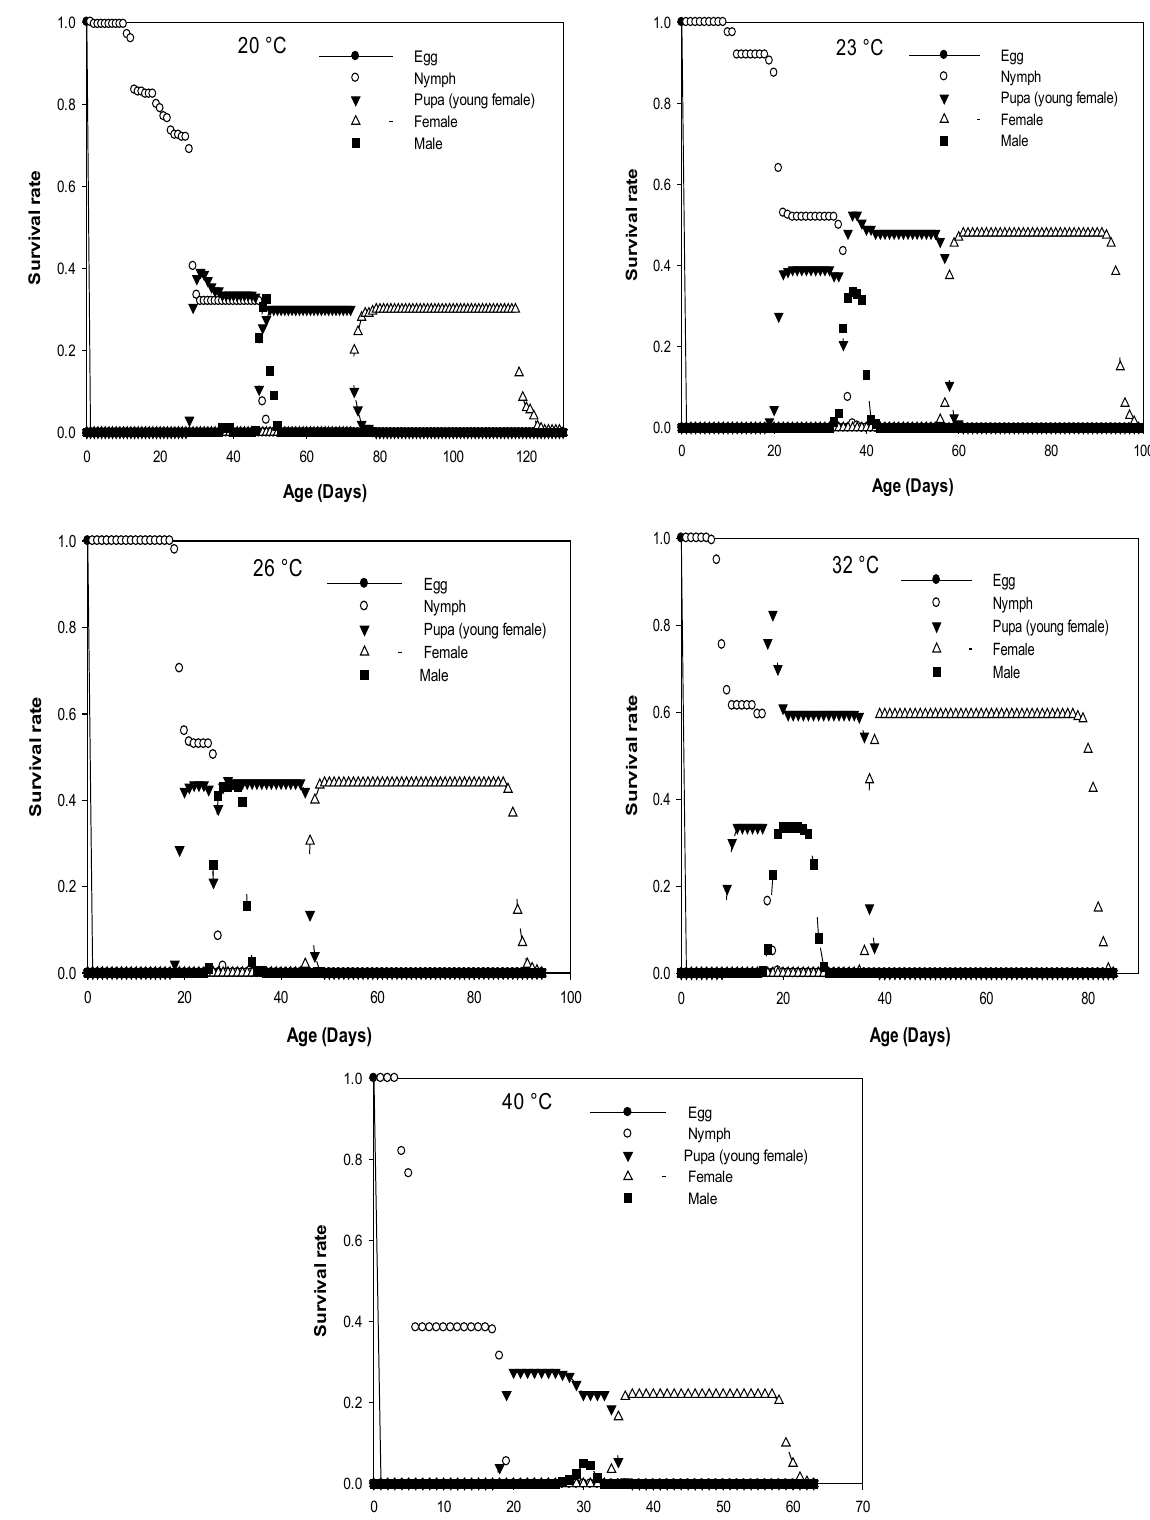
Figure 1. Age-stage specific survival rate (s xj ) calculated for D. opuntia fed on O. ficus-indica at five different constant